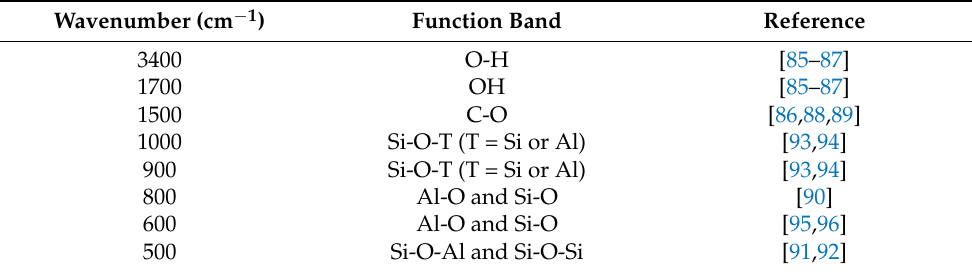
Table 3. Summary of bands in the FTIR